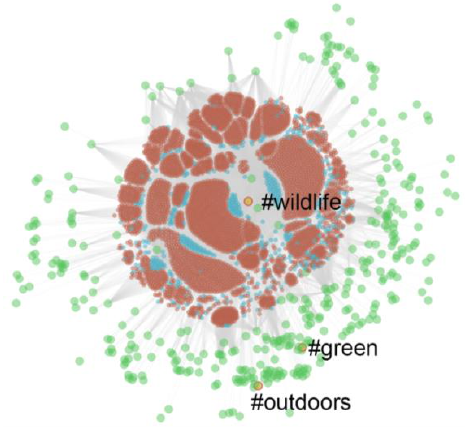
Figure 4. Hashtags appearing in tweets that were retweeted more than 5000 times.